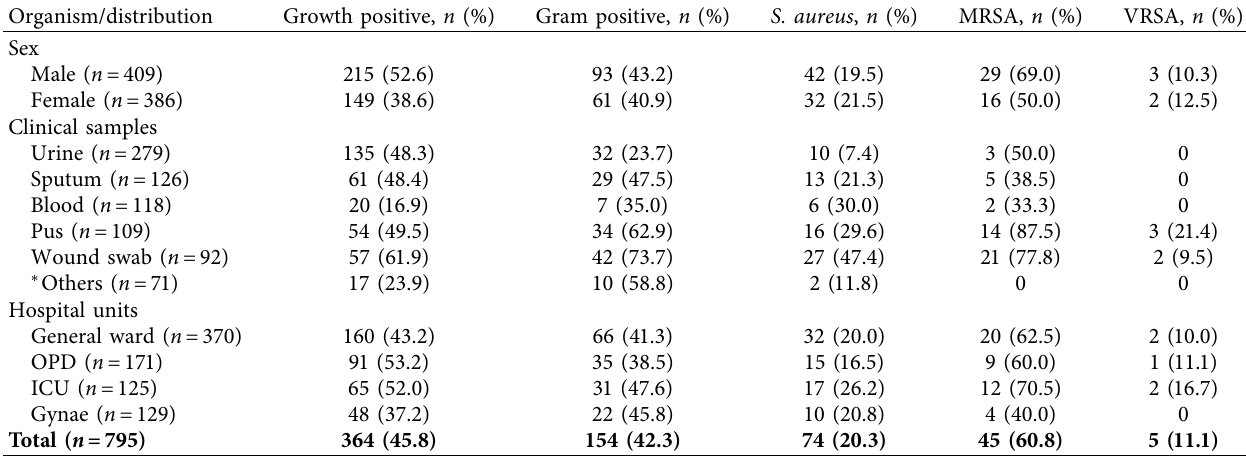
Table 1: Distribution of MRSA and VRSA isolates.